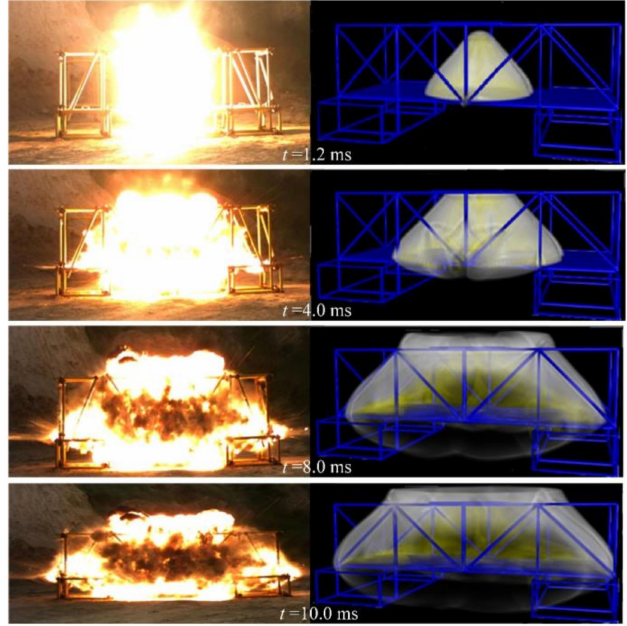
Figure A2. Comparison between the scenario without explosion height and the experimental